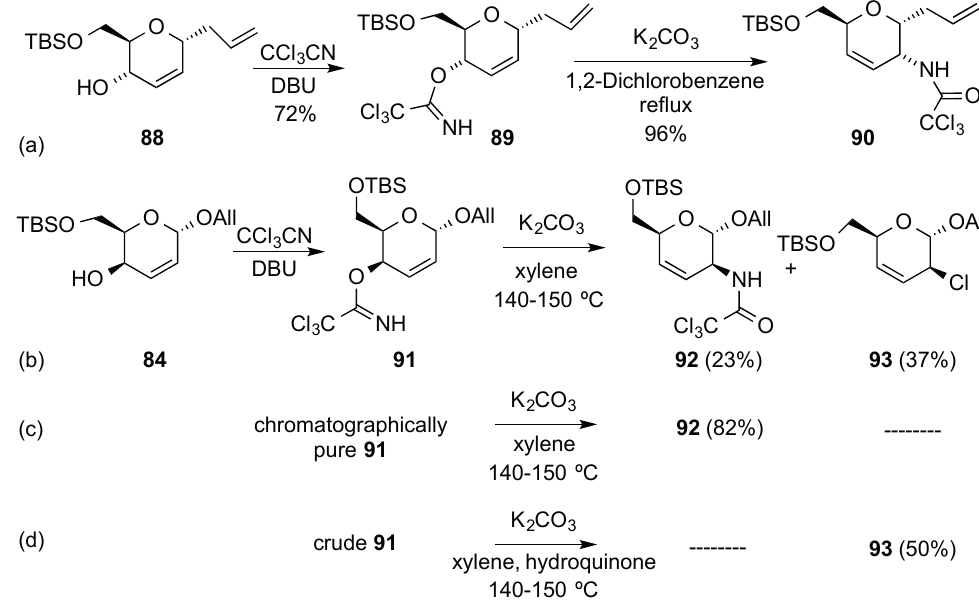
Scheme 20. Sigmatropic rearrangement of allyl phenyl ethers.